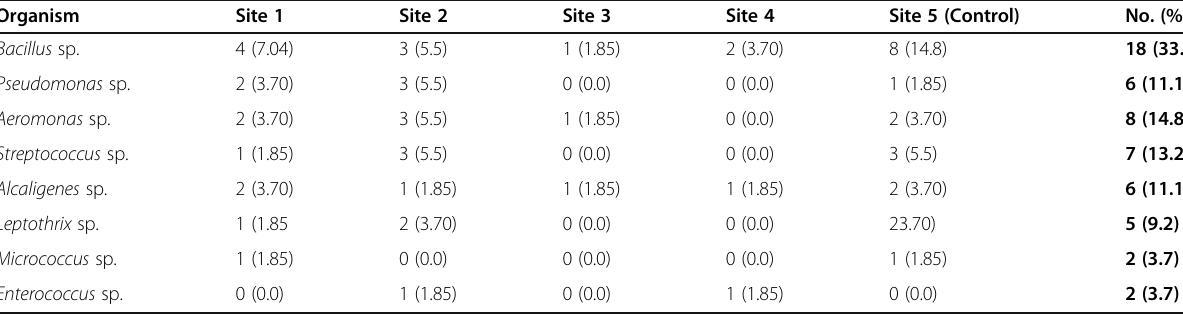
Table 5 Frequency of occurrence of aerobic heterotrophic bacteria from soil of the mining sites Organism Site 1 Site 2 Site 3 Site 4 Site 5 (Control) No. (%) Bacillus sp. Pseudomonas